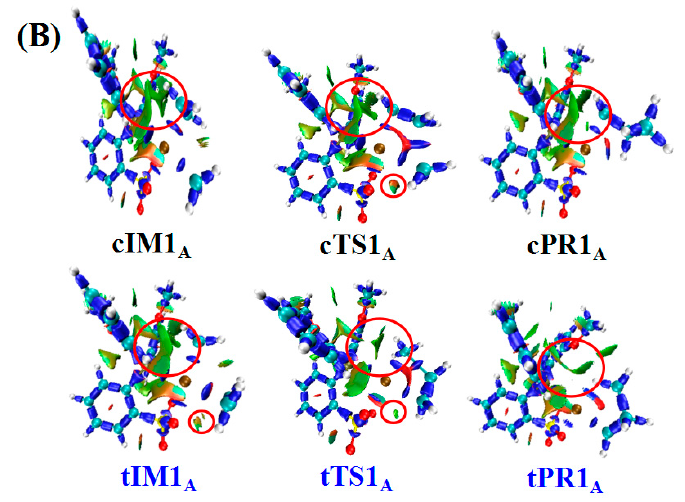
Figure 2. ( A ) Optimized structures in the first ethylene insertion reaction pathway shown in Figure 1, cis -mode (black) and trans -mode (blue), the key length is in angstroms. ( B ) Interaction region indicator (IRI) analysis of key structures with the noncovalent weak interactions highlighted by the red circles.